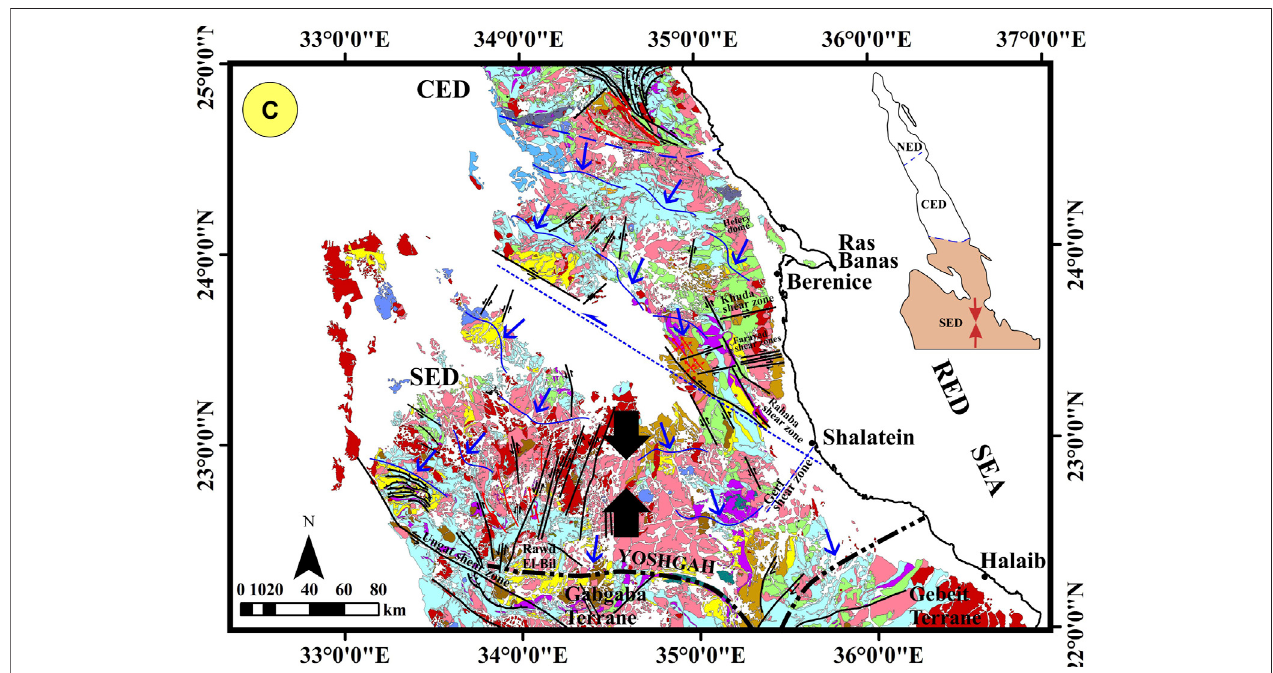
FIGURE 6 | (Continued). The geologic map of the Late Neoproterozoic belt of Egypt. (A) NED, (B) CED, and (C) SED. Discrimination of various lithologies and structural provinces based on image processing of Landsat-8 OLI data and ground intensive fi eld/structural work.